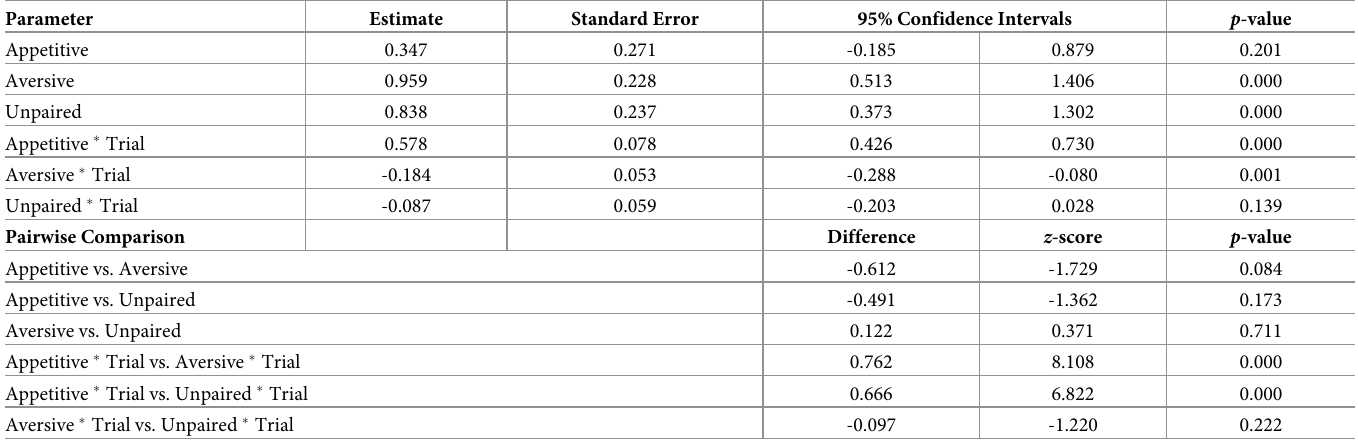
Table 4. Experiment 1 conditioning CS MPR